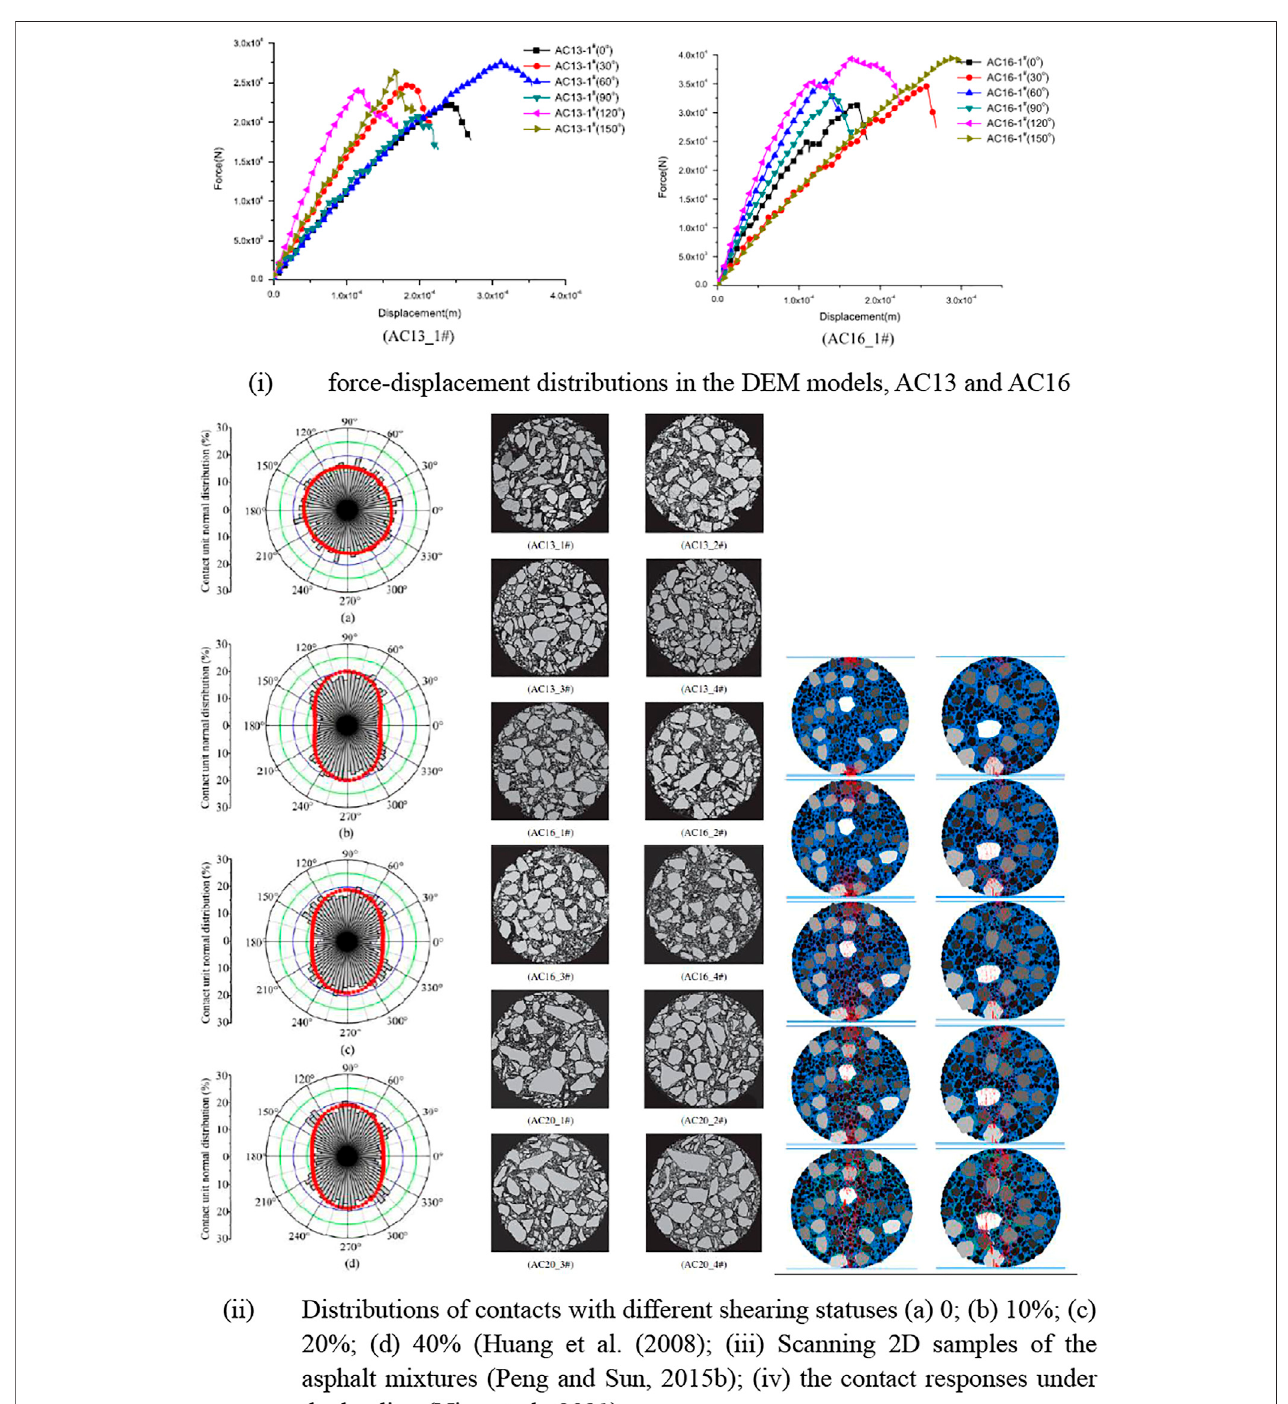
FIGURE 4 | Load-displacement curves of the splitting test (indirect tensile test) and contact distributions (Peng and Sun, 2015b; Huang et al., 2008; Nian et al., 2021). (i) force-displacement distributions in the DEM models, AC13 and AC16. (ii) Distributions of contacts with different shearing statuses (A) 0; (B) 10%; (C) 20%; (D) 40% (Huang et al., 2008); (iii) Scanning 2D samples of the asphalt mixtures(Peng and Sun, 2015b); (iv) the contact responses under the loading (Nian et al., 2021).